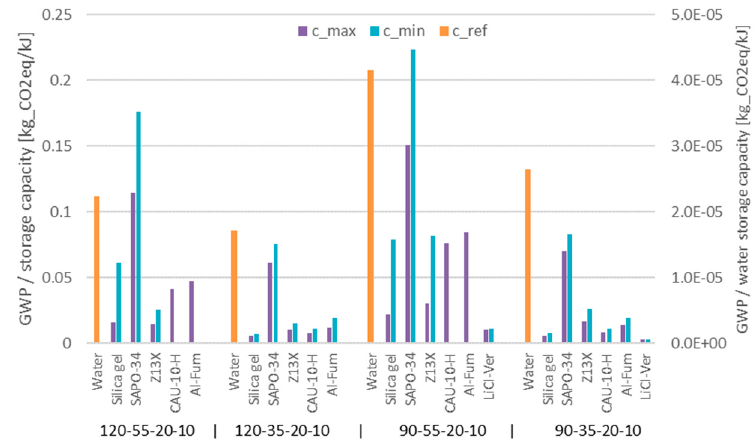
Figure 9. Global warming potential per storage capacity of selected materials (left axis: sorption materials; right axis: water) for different boundary conditions (T des -T ads -T cond -T evap ); for MOFs and T ads = 55 °C, c min is negative, so no values are shown.